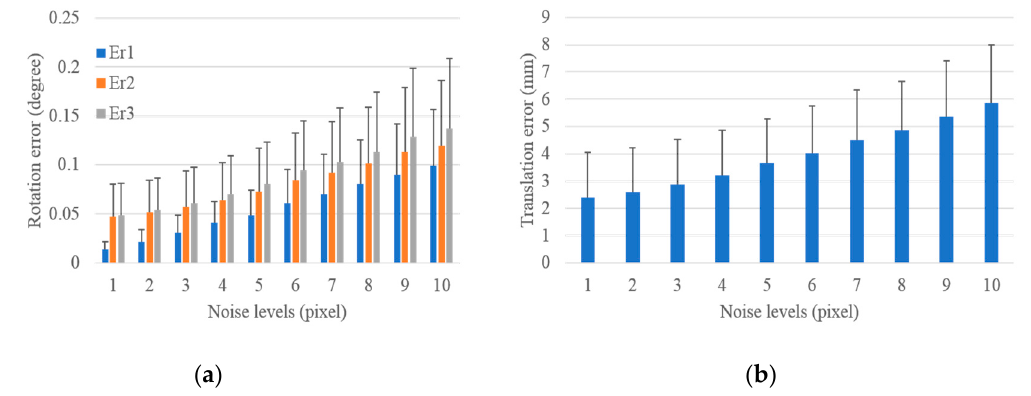
Figure 10. Rotation and translation errors for the extrinsic calibration of LRF with respect to camera with outliers added in image. ( a ) Rotation error and ( b ) translation error.